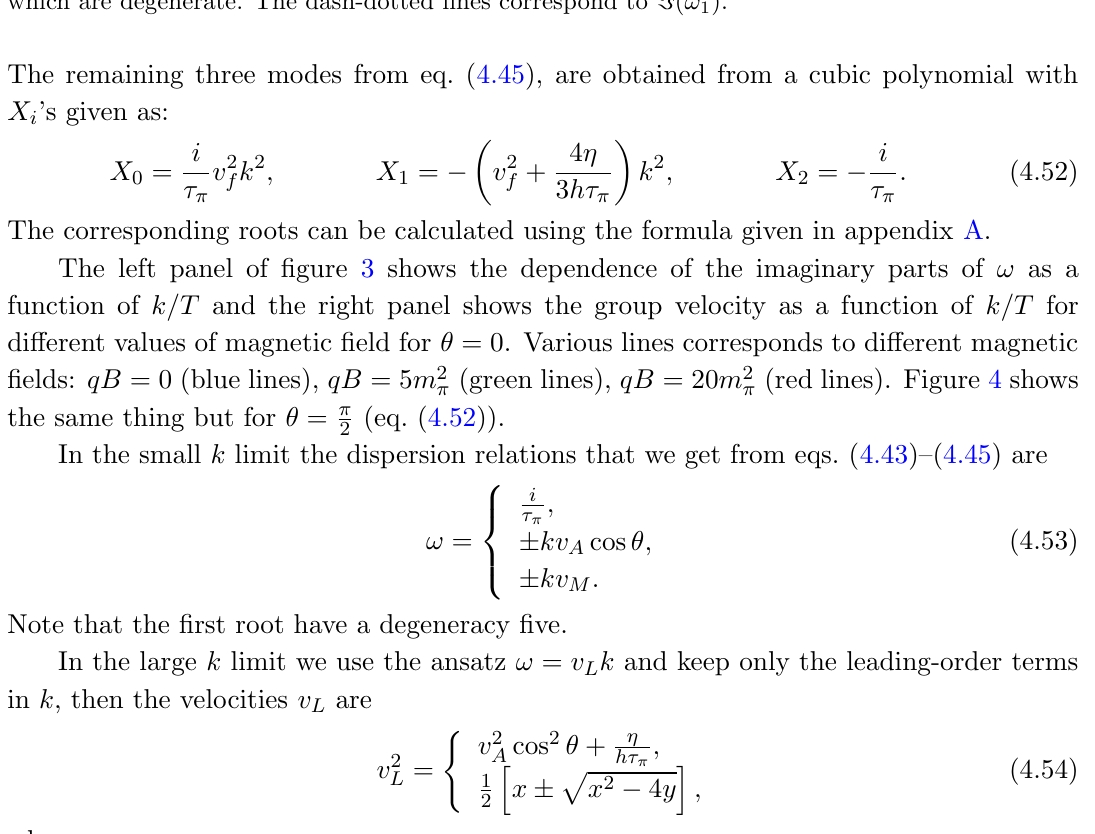
Figure 3 . (Color online) The left panel shows the imaginary parts of the dispersion relations and the right panel shows the group velocities obtained from a cubic polynomial with the coe(cid:14)cients given in eq. (4.48) for (cid:18) = 0. The other parameters used are a = 0 : 1 ; (cid:11) = 1 = 3 ; T = 200 MeV ; (cid:28) (cid:25) = 0 : 985 fm and their values are kept (cid:12)xed for all the curves. In the left panel, the solid lines are for = ( ! 2 ; 3 ) which are degenerate. The dash-dotted lines correspond to = ( ! 1